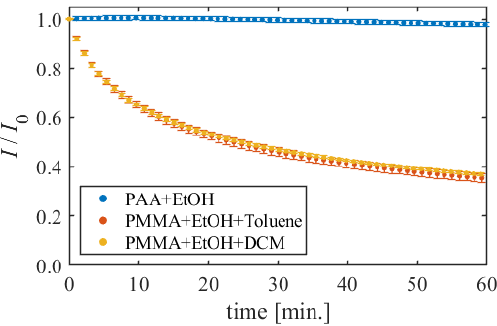
Figure 12. Comparison of photodegradation in different dye concentrations.